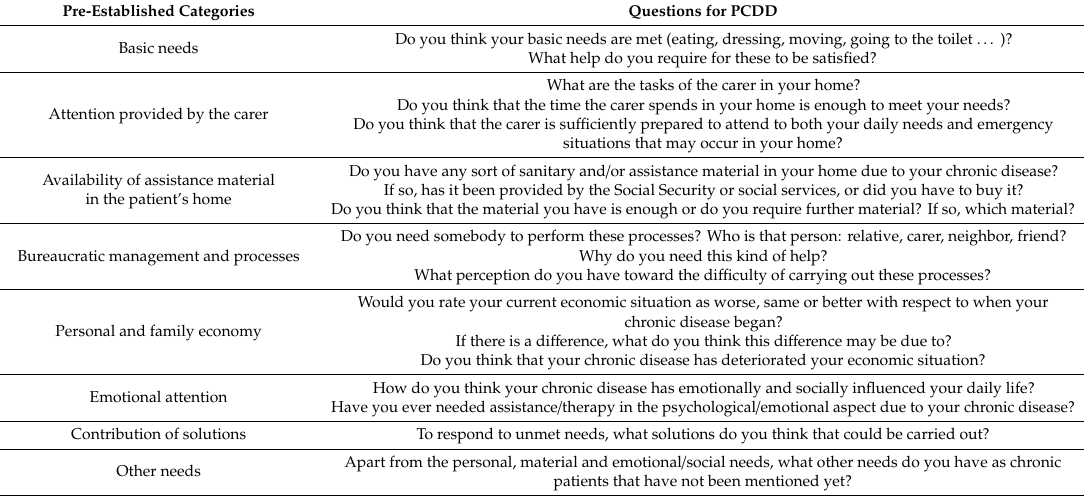
Table 2. Main questions asked in the focus groups and interviews with